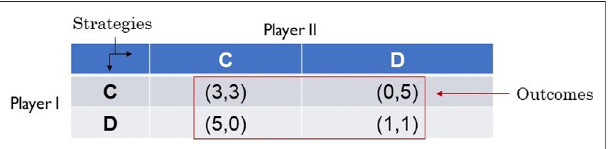
FIGURE 1 | Prisoner ’ s dilemma.